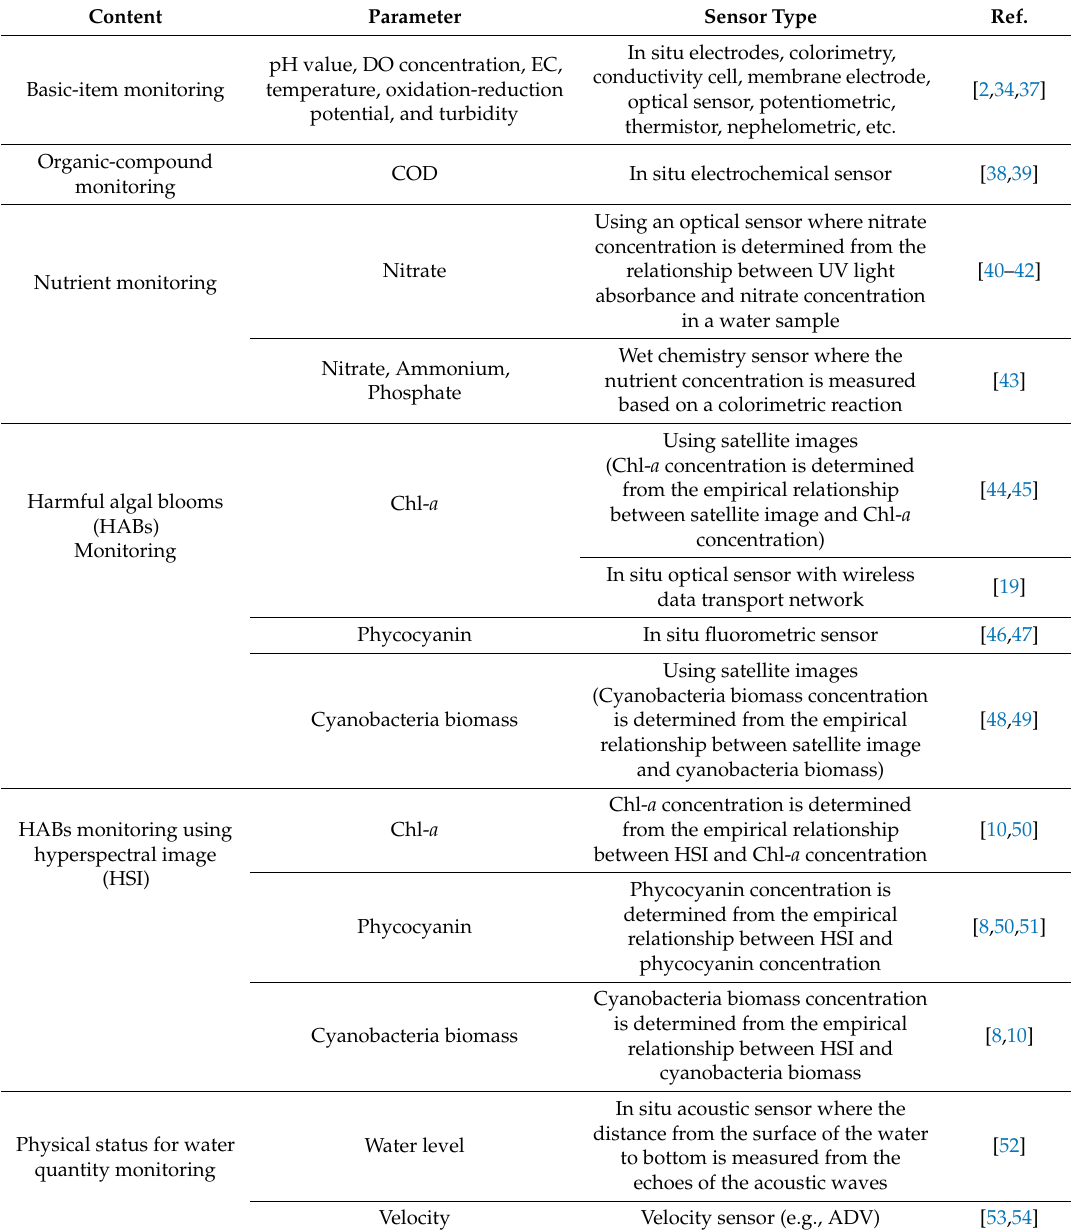
Table 1. Examples of water quality parameters monitored with sensing